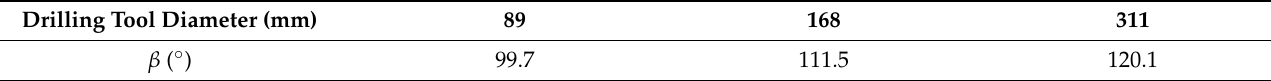
Table 2. Angle β corresponding to different